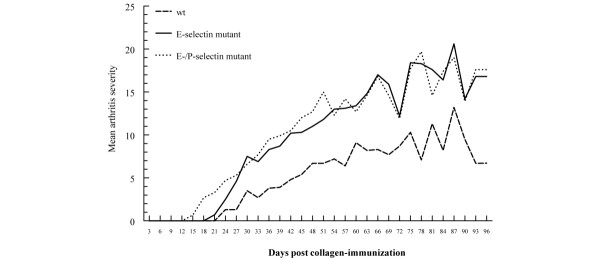
Arthritis severity in E-selectin mutant, E/P-selectin mutant, and wild-type mice. Arthritic paws were evaluated for the severity of inflammation and the presence of distortion and ankylosis as described in the Materials and method section. Daily severity scores were calculated from the combined inflammation, distortion, and ankylosis scores. Data are shown from three separate CIA experiments, and the mean arthritis severity is shown for each genotype. P < 0.05 for both E-selectin and E/P-selectin mutant versus wild type mice. wt, wild-type.